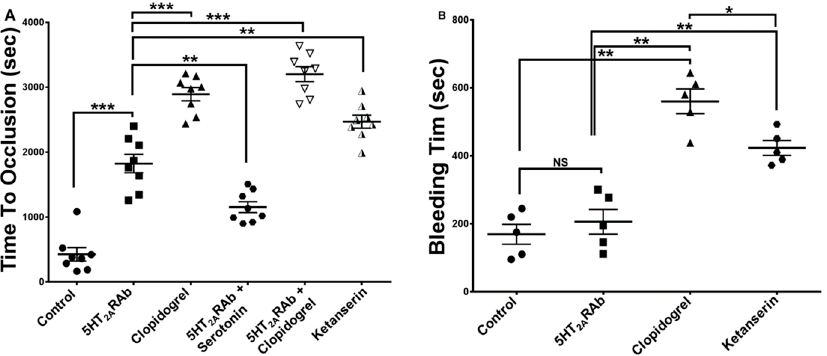
Figure 6. The 5HT 2A RAb prolongs the time to occlusion but, unlike clopidogrel and ketanserin, does not prolong the tail bleeding time, in mice. Mice were injected via the tail vein with 150 nM 5HT 2A RAb, once daily for 5 days, 1 mg/kg of the 5HT 2A R antagonist ketanserin, or 6 mg/kg clopidogrel two hours before being subjected to the FeCl 3 thrombosis and tail bleeding time models. ( A ) Mean occlusion times for mice treated with vehicle, 150 nM 5HT 2A RAb, 6 mg/kg clopidogrel, a combination of 50 nM 5HT 2A RAb and 3 mg/kg clopidogrel, with 150 nM 5HT 2A RAb followed by 1 mg/kg serotonin, or with 1 mg/kg ketanserin (n = 8 in each case). ( B ) Mean bleeding times for mice treated with vehicle, 150 nM 5HT 2A RAb, 6 mg/kg clopidogrel, or 1 mg/kg ketanserin (n = 5 in each case). Each point represents the occlusion time or tail bleeding time of a single animal. Data were compared by running the Mann–Whitney test using GraphPad Prism (*** p < 0.001; ** p < 0.01; * p < 0.05; NS, nonsignificant).